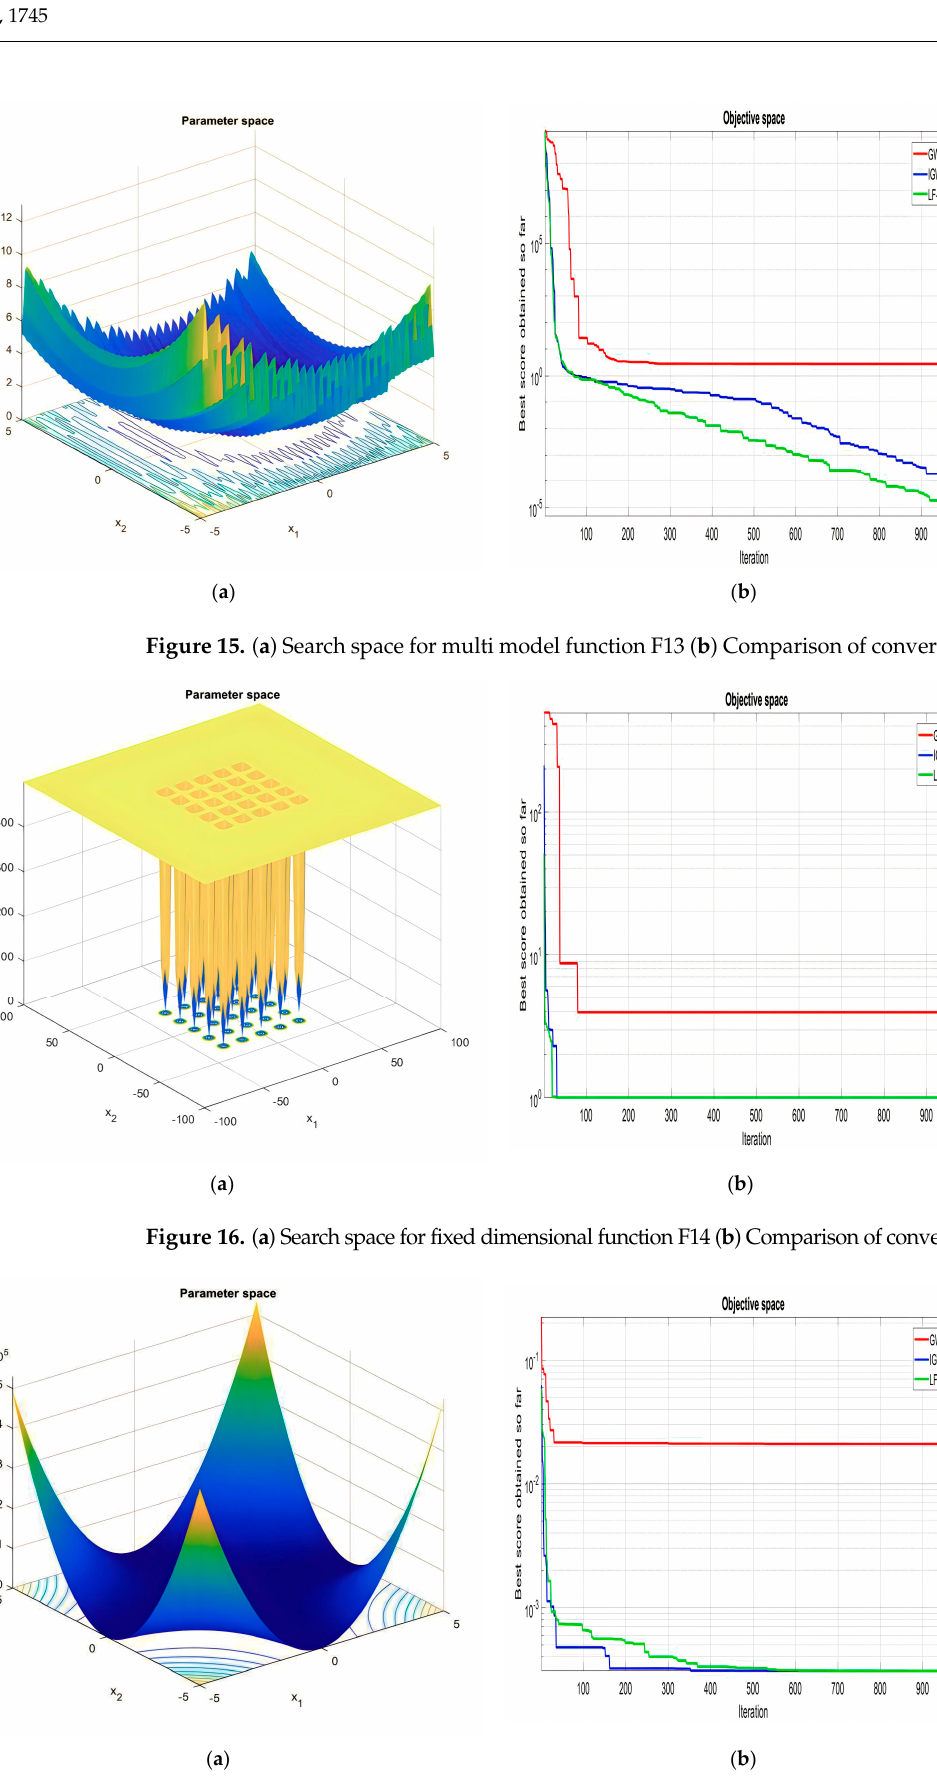
Figure 14. ( a ) Search space for multi model function F12 ( b ) Comparison of convergence curve for F12.